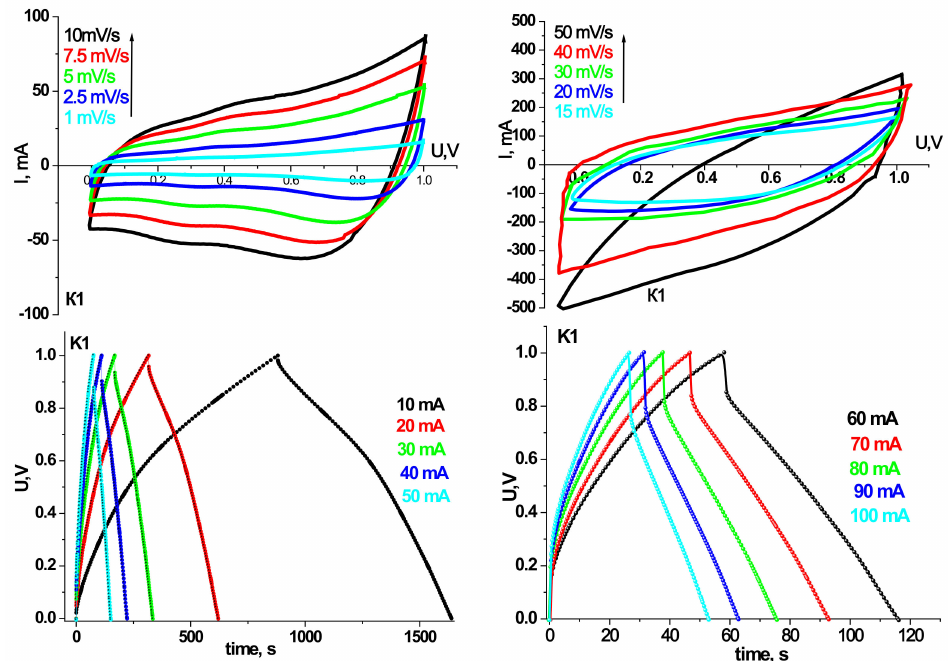
Figure 7. CVA and charge/discharge curves of the layout of HSCs based on the material K1.